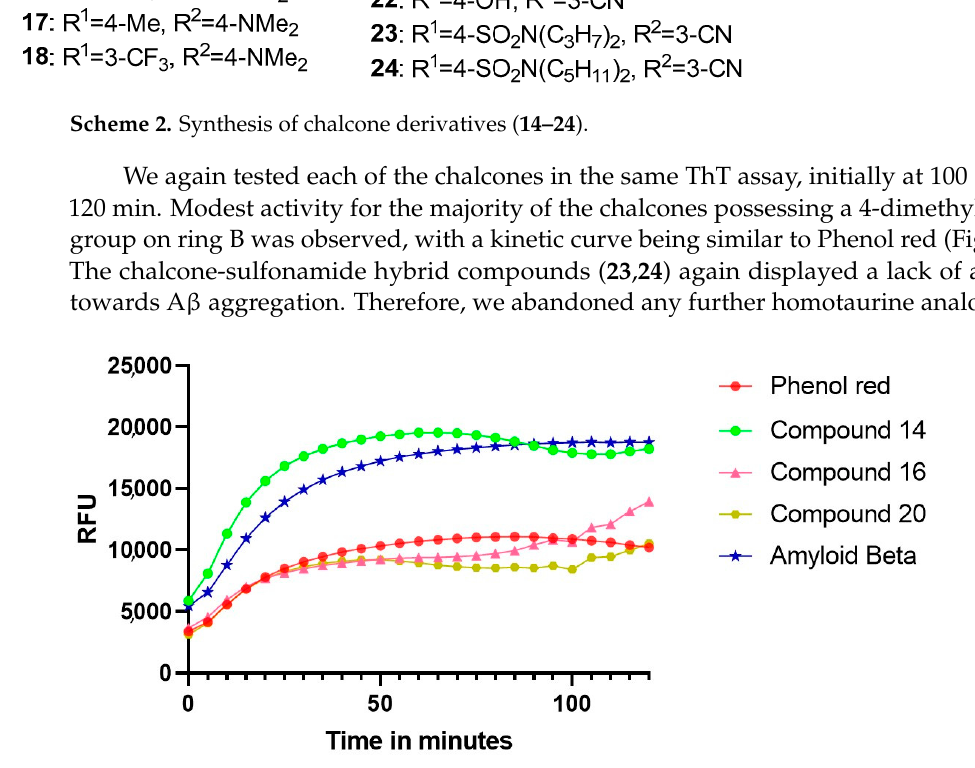
Figure 3. Select ThT fluorescence assay of chalcone compounds 14, 16, and 20 at 100 µ M. Phenol red 100 µ M is a positive control. Fluorescence was recorded every 5 min for 120 min.